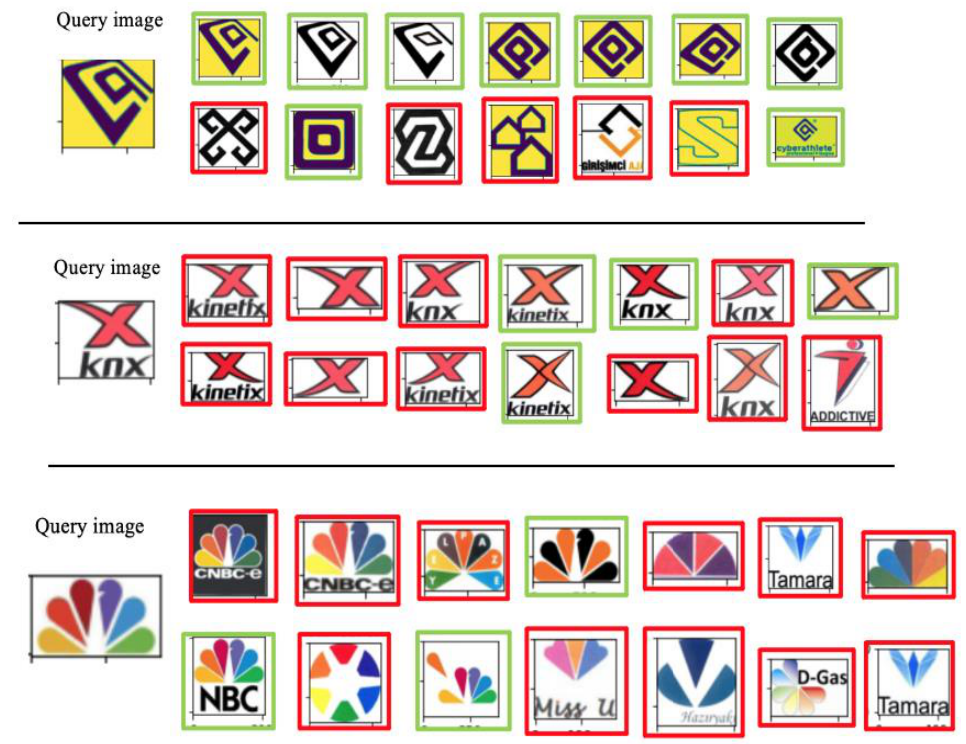
Figure 4. Some examples of the images retrieved for a given query.